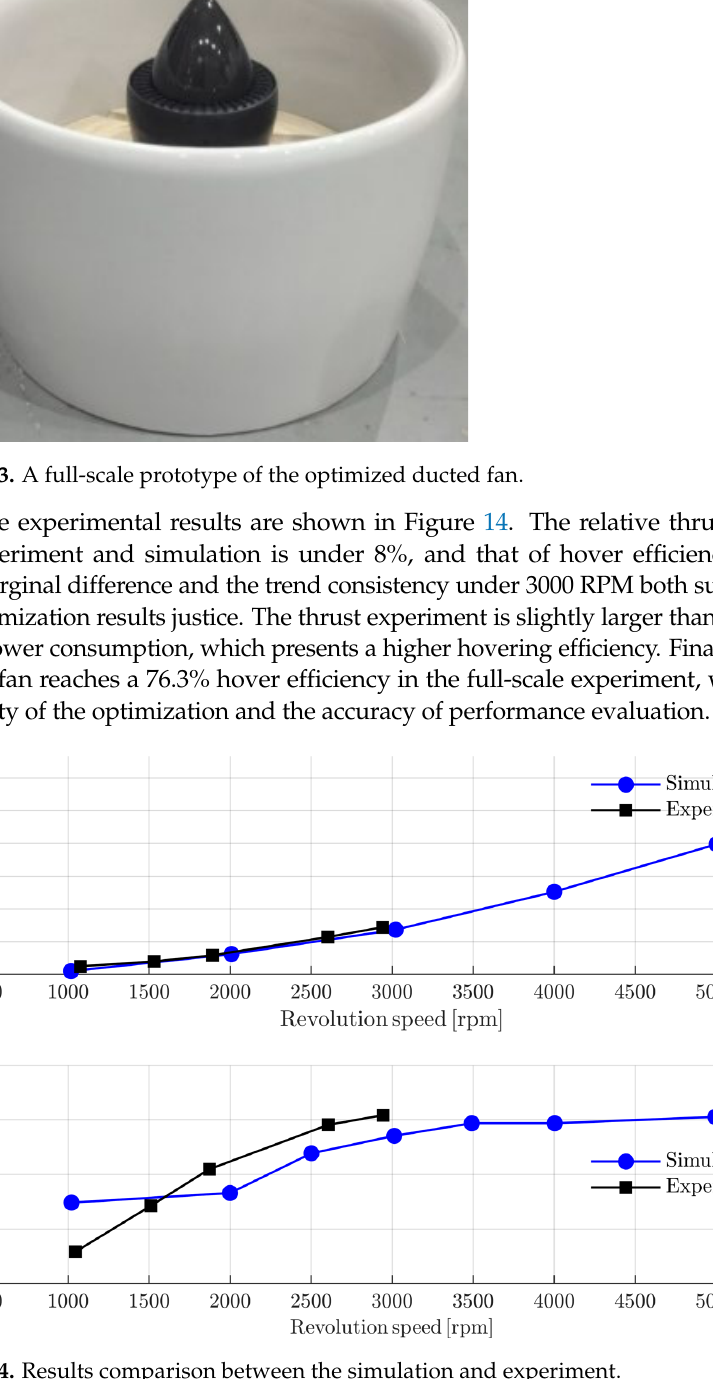
Figure 14. Results comparison between the simulation and